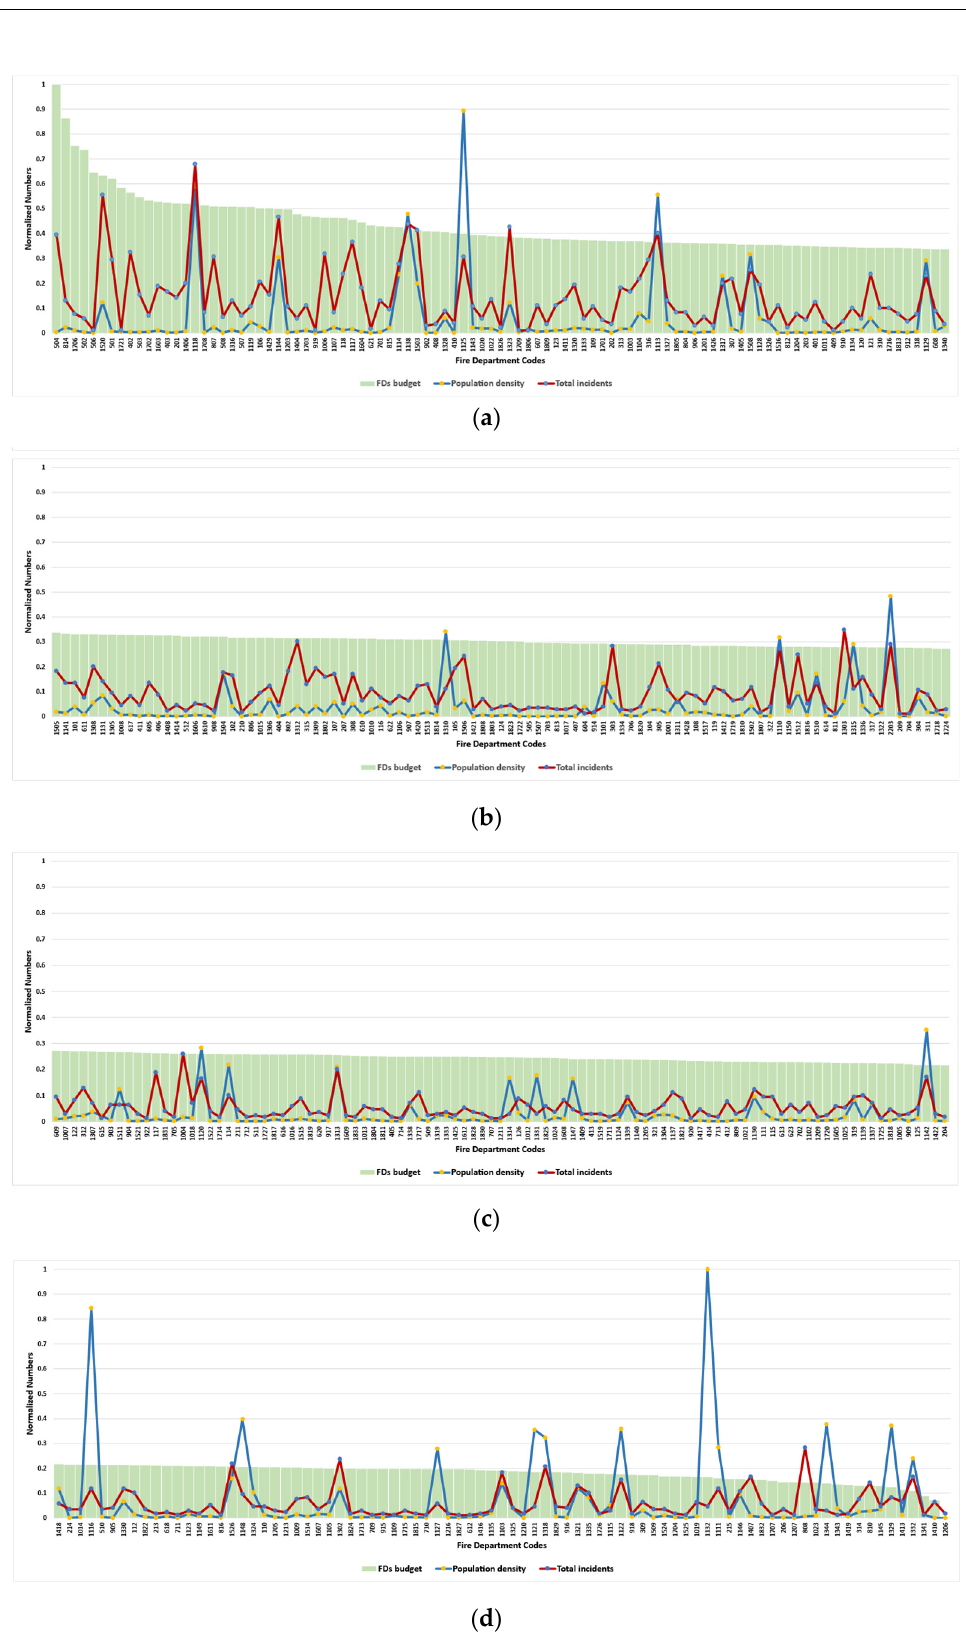
Figure 3. ( a – d ). FDs’ budgets, populations densities, and number of incidents in 2020.